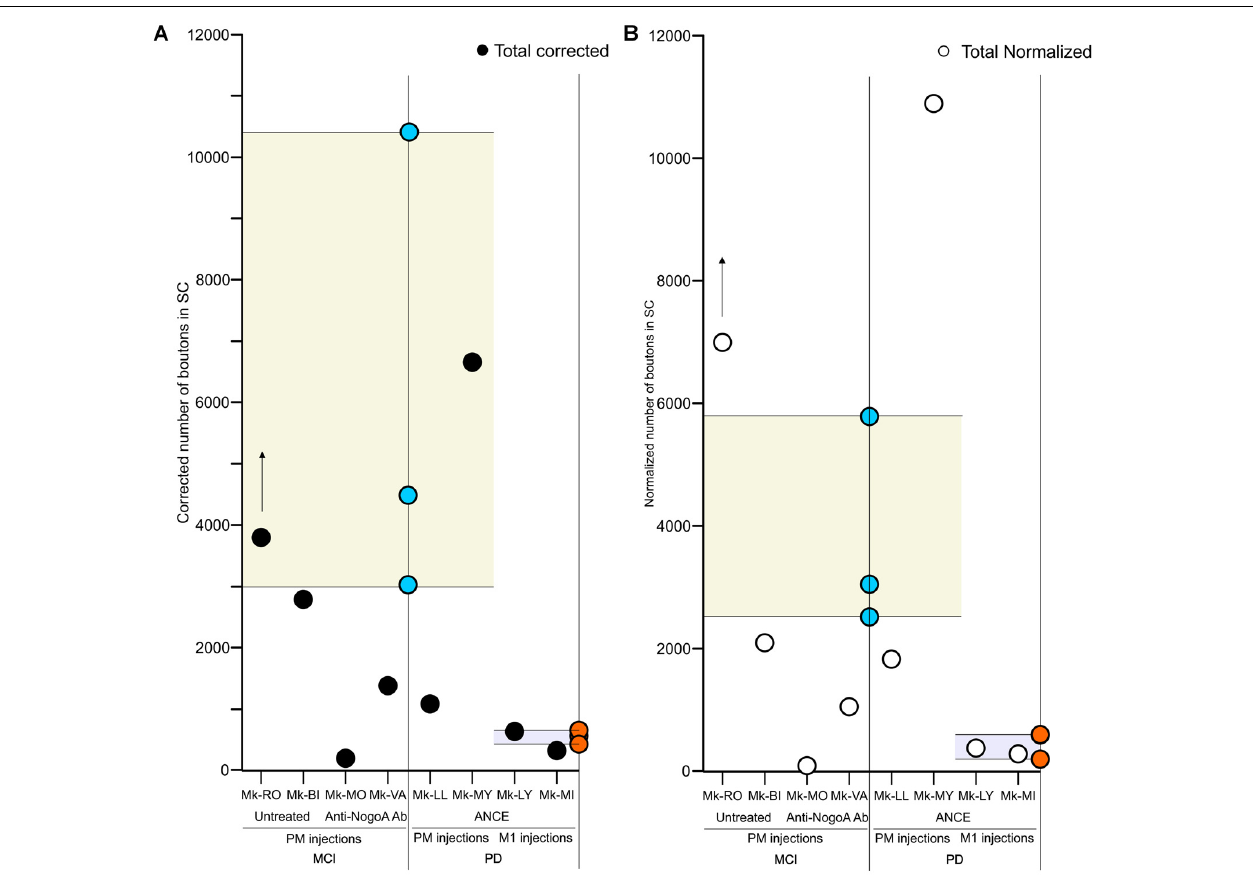
FIGURE 3 | Scatter plots of the total numbers of corticotectal boutons observed in the SC in the different groups of monkeys subjected to motor cortex injury (MCI) or MPTP intoxication (PD). The data are restricted to the ipsilateral SC with respect to the BDA injection site, either in PM or M1. For comparison, the corresponding data in intact monkeys (Fregosi and Rouiller, 2017) are represented here by the range derived from intact cases (yellow or light blue areas), with individual data points in blue (PM projection in intact monkeys) or in brown (M1 projection in intact monkeys). The individual data points for the corticotectal projections (present study) are indicated with black or open white symbols for absolute data or normalized data, respectively ( A,B , respectively). The BDA injection site (PM or M1) is indicated below the graph. Panel (A) is for the absolute numbers of corticotectal boutons, whereas (B) is for normalized numbers of corticotectal boutons. The presence/absence of treatment is indicated below the graphs. In both panels, the data were corrected with respect to the distance between consecutive sections (see “Materials and Methods” section). For Mk-RO, the vertical arrow indicates that the number of axonal boutons in SC was underestimated, due to a few missing histological sections (see “Results”